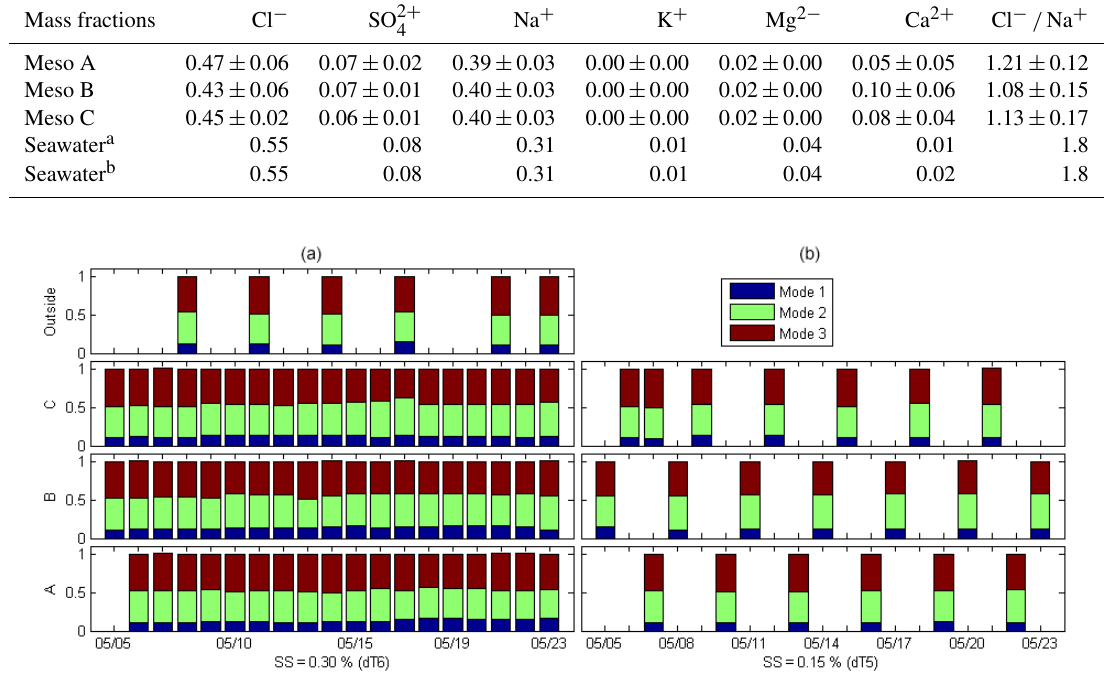
Figure 3. Number fraction of SMPS log normal modes in mesocosms A, B and C and outside water at SS = 0.30% (a) and SS = 0.15% (b)